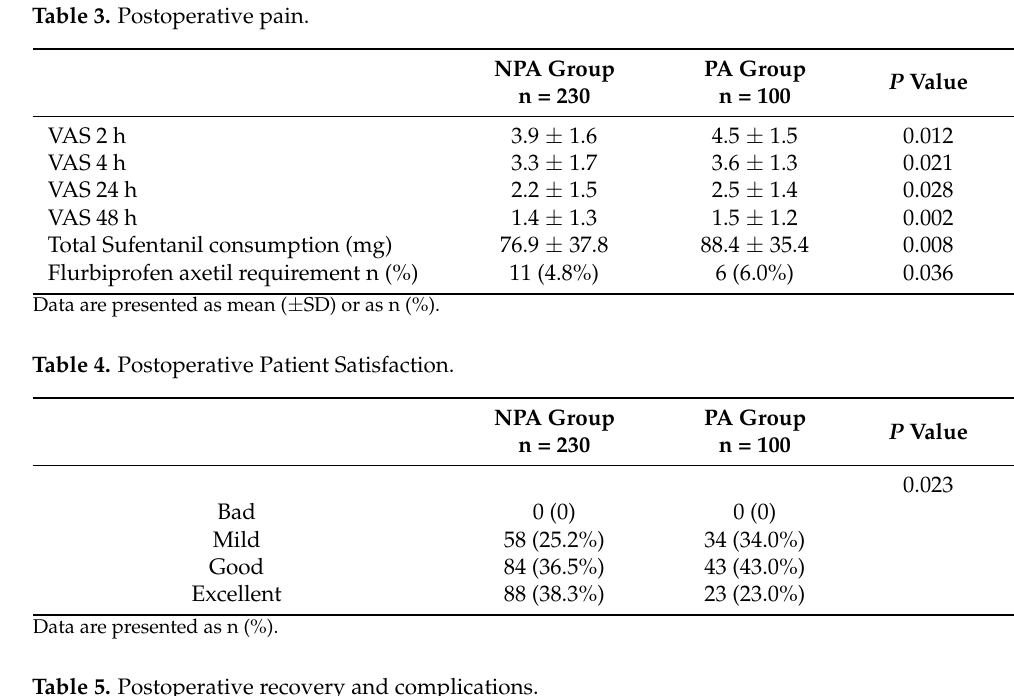
Table 5. Postoperative recovery and